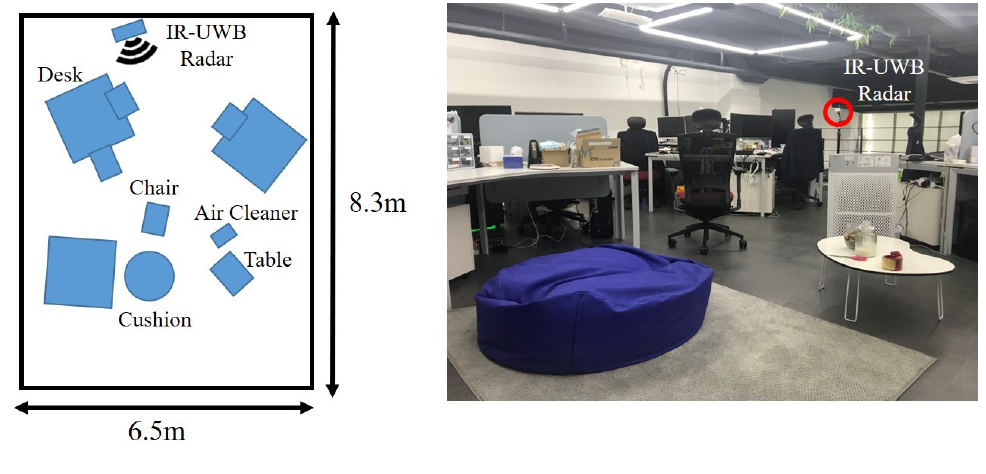
Figure 14. Heavy clutter